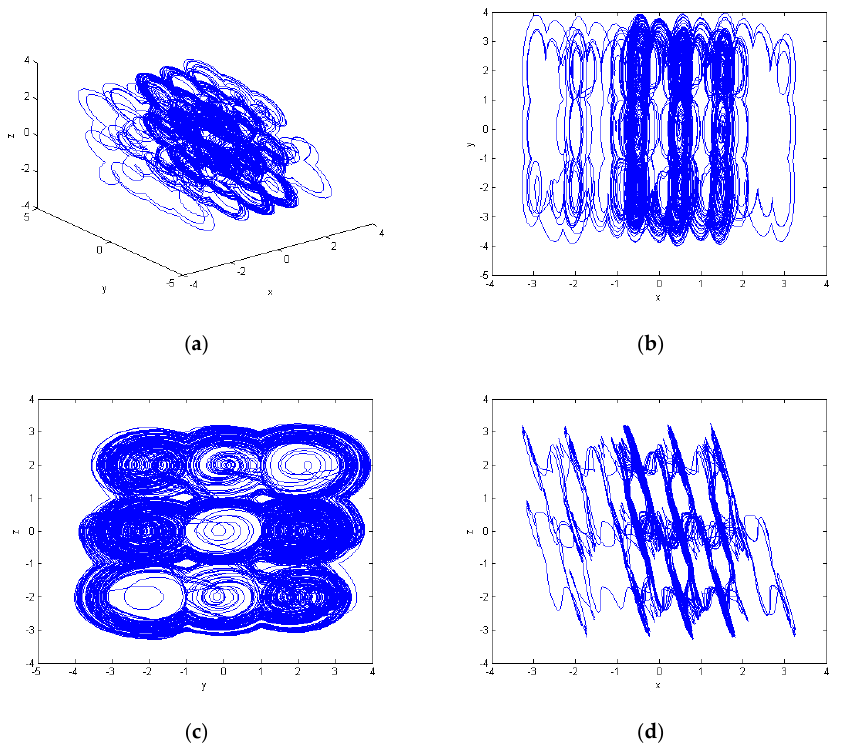
Figure 7. (Color online) 12 × 3 × 3-scroll chaotic attractor of system (2) with 1 1 n = , 2 2 n = , Figure7. (Coloronline)6 × 3 × 3-scrollchaoticattractorofsystem(2)with n 1 = 1, n 2 = 2, f 1 ( y ) = f 11 ( y ) , ( ) ( ) f 2 ( z ) = f 21 ( z ) , N 11 = 0, N 21 = 0, e = 5.0, and ( x 0 , y 0 , z 0 ) = ( 0.1,0,0 ) : ( a ) x–y–z plane; ( b ) projection on 1 plane; ( b ) projection on the x–y plane; ( c ) projection the y–z plane; and ( d ) projection on the x–z the x–y plane; ( c ) projection the y–z plane; and ( d ) projection on the x–z plane. plane.